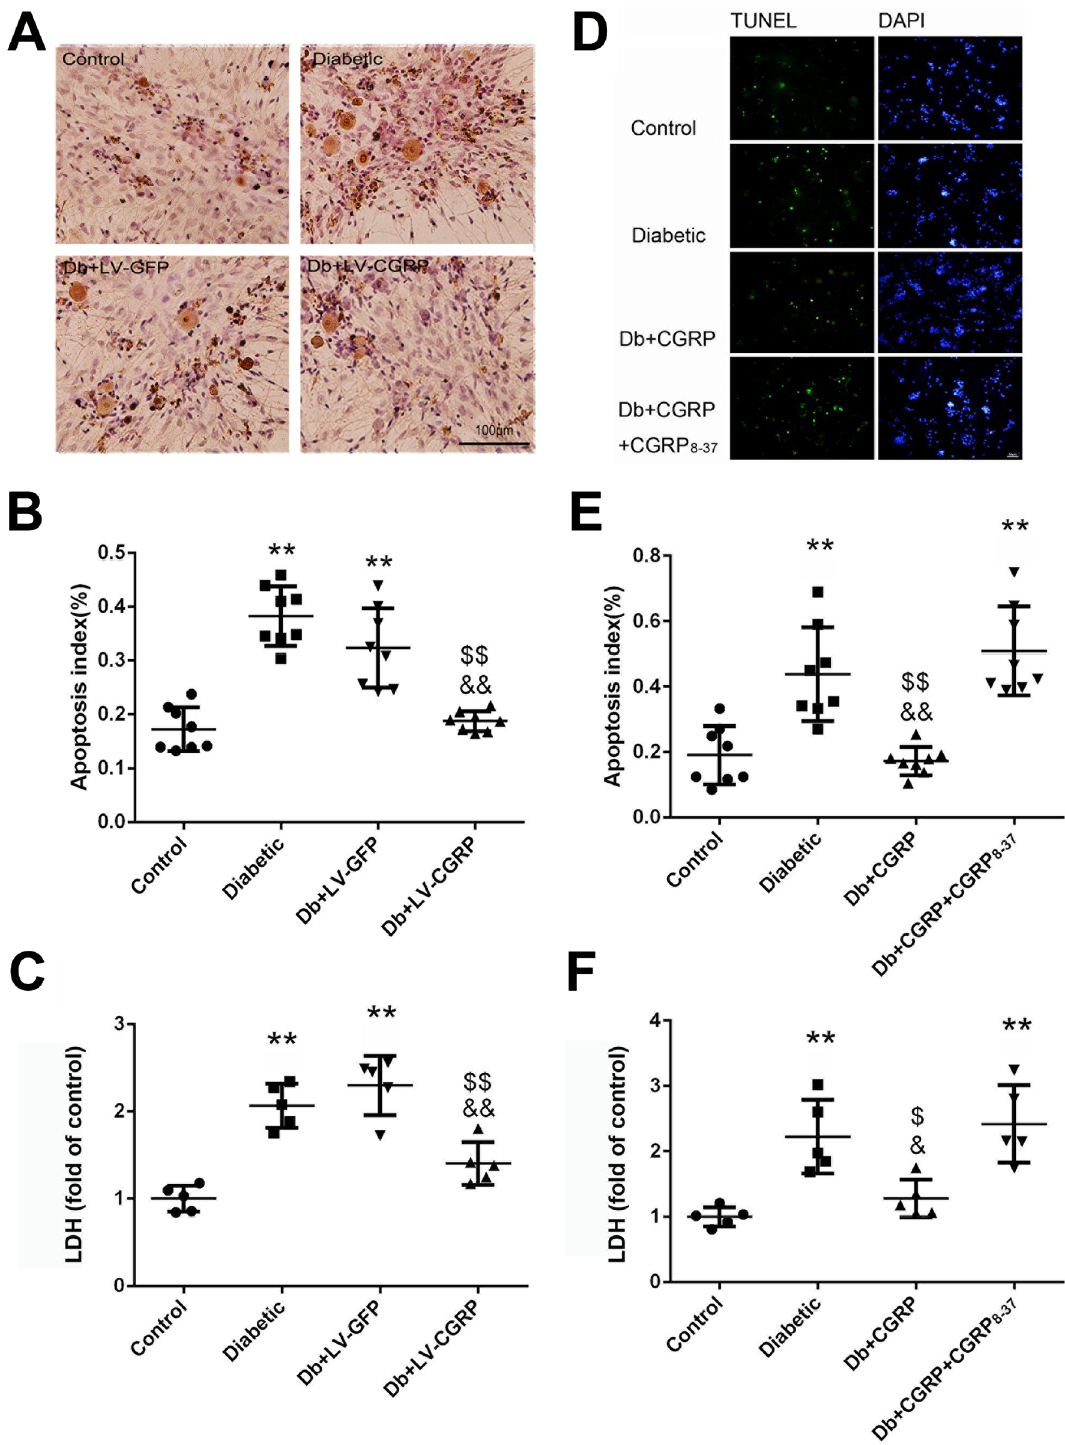
Figure 6. Transfection of LV-CGRP and exogenous CGRP alleviated neuronal injury of the DRG neurons. Transfection of CGRP genes effectively alleviated the apoptotic changes of the dissociated DRG neurons from the diabetic animals ( A , B ) and reduced the elevation of LDH in the culture medium ( C ). Exogenously administered CGRP (at 10 −8 mol/L, the final concentration) produced the same protective effects on the apoptotic changes ( D , E ) and the LDH ( F ). The effects of CGRP were completely reversed by CGRP 8–37, a specific antagonist of CGRP receptor (at 10 −7 mol/L, the final concentration). Control the neurons from the age matched non-diabetic animals, Diabetic the neurons from the diabetic animals, Db + LV-GFP DRG neurons from diabetic animals transfected with GFP genes, Db + LV-CGRP DRG neurons from diabetic animals transfected with CGRP genes. Db + CGRP the neurons collected from the diabetic animals treated with CGRP, Db + CGRP + CGRP 8–37 the neurons collected from the diabetic animals treated by CGRP 8–37 then by CGRP. ** p < 0.01, compared to the control; $ p < 0.05, compared to diabetic group; $$ p < 0.01, compared to Diabetic group; & p < 0.05, compared to Db + CGRP + CGRP 8–37 group; && p < 0.01, compared to Db + LV-GFP group or Db + CGRP + CGRP 8–37 group. The scales = 100 µm in ( A ) and 50 µm in ( D ),